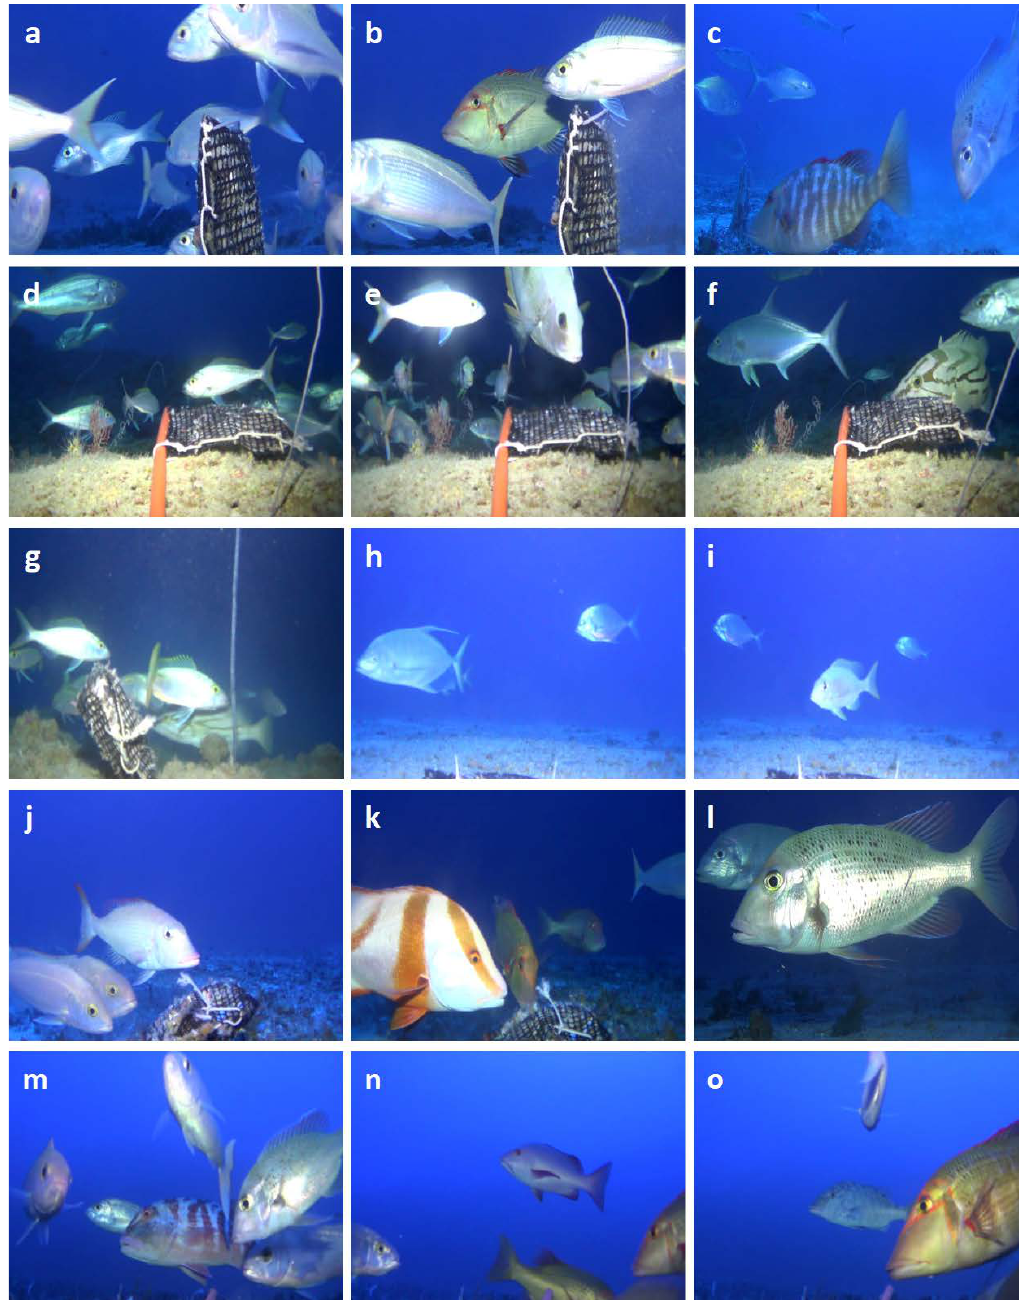
Figure 8. Examples of fish co-occurrences on deep reefs of the Great Barrier Reef shelf-break: ( a,b